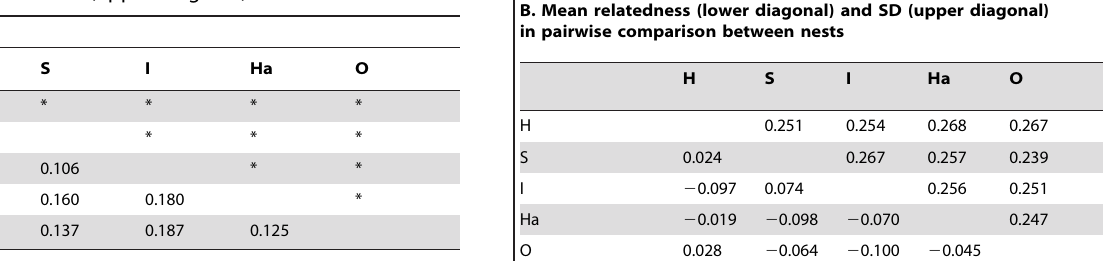
Table 2. Pairwise genetic distance, F ST (lower diagonal), and statistical significance (upper diagonal).